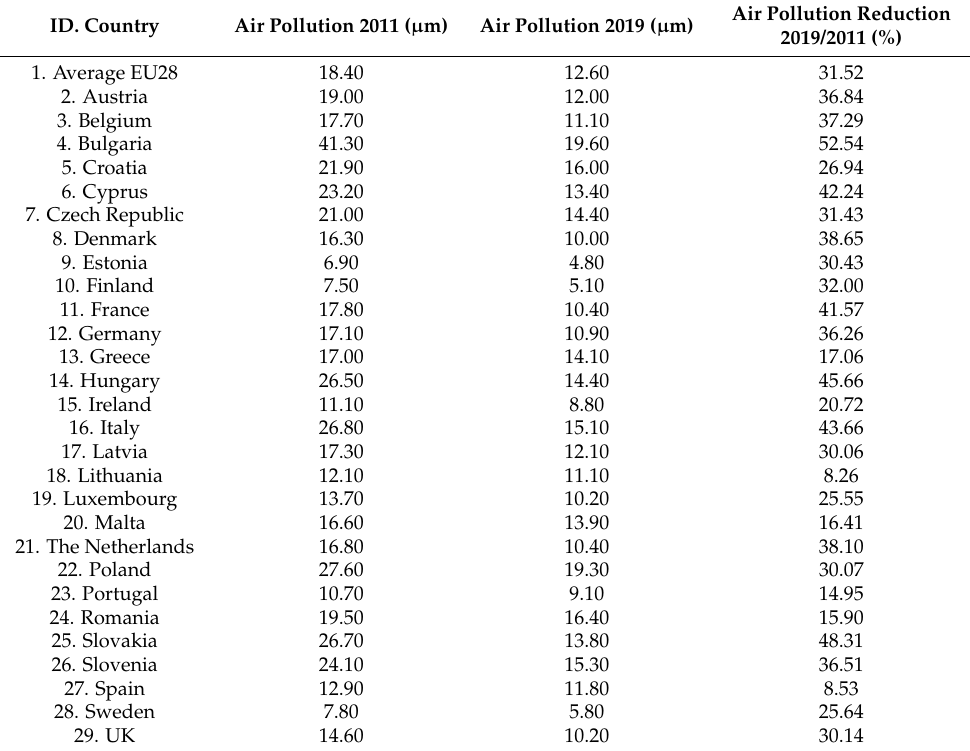
Table 4. Exposure to air pollution by particulate matter dynamics in 2019 as compared to 2011. ID.